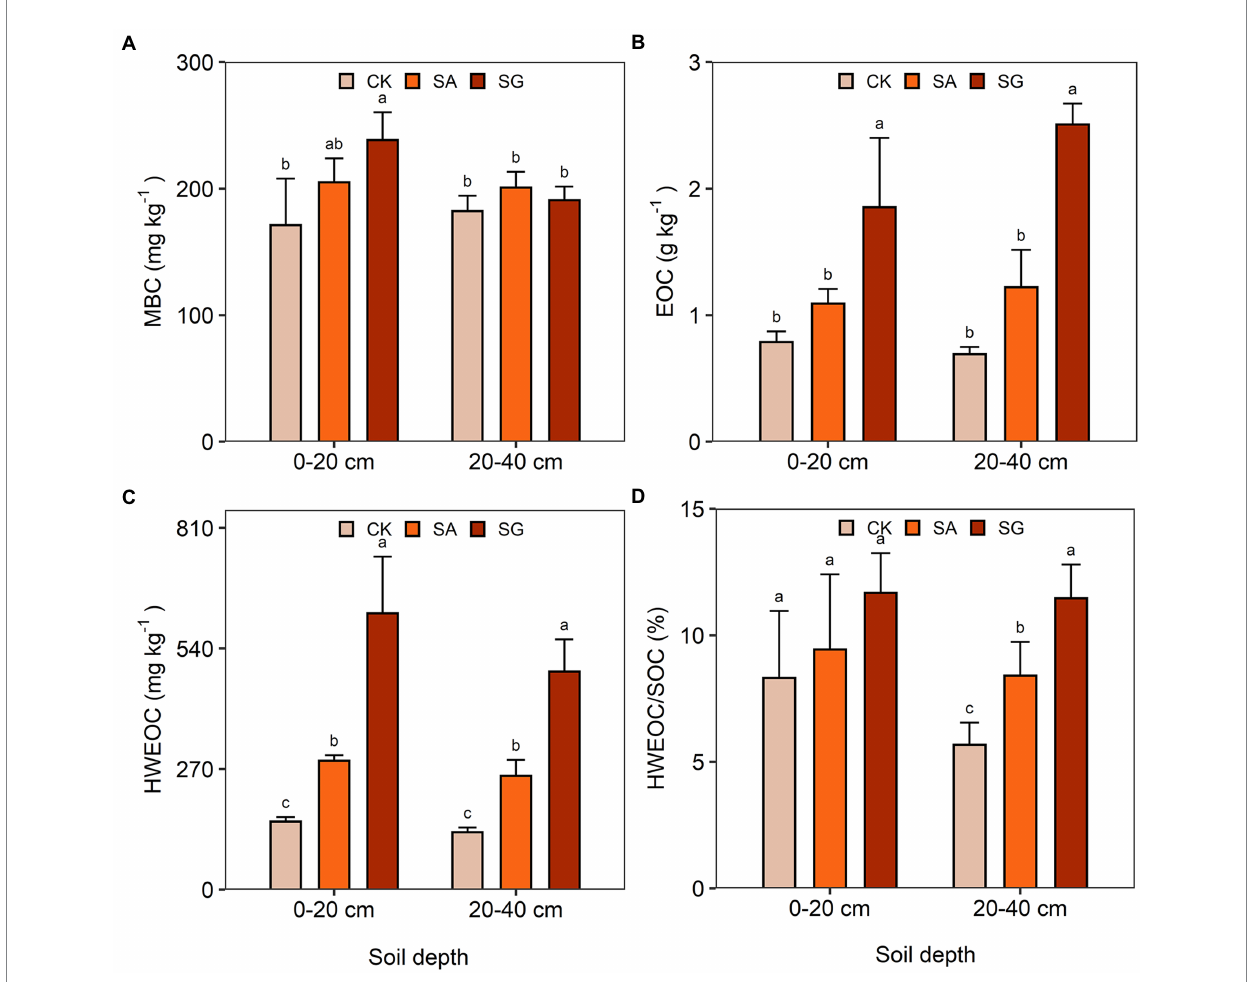
indicate standard deviation; Different lowercase letters indicate significant differences at p < 0.05 among treatments, based on the Tukey’s honest significance difference (HSD)